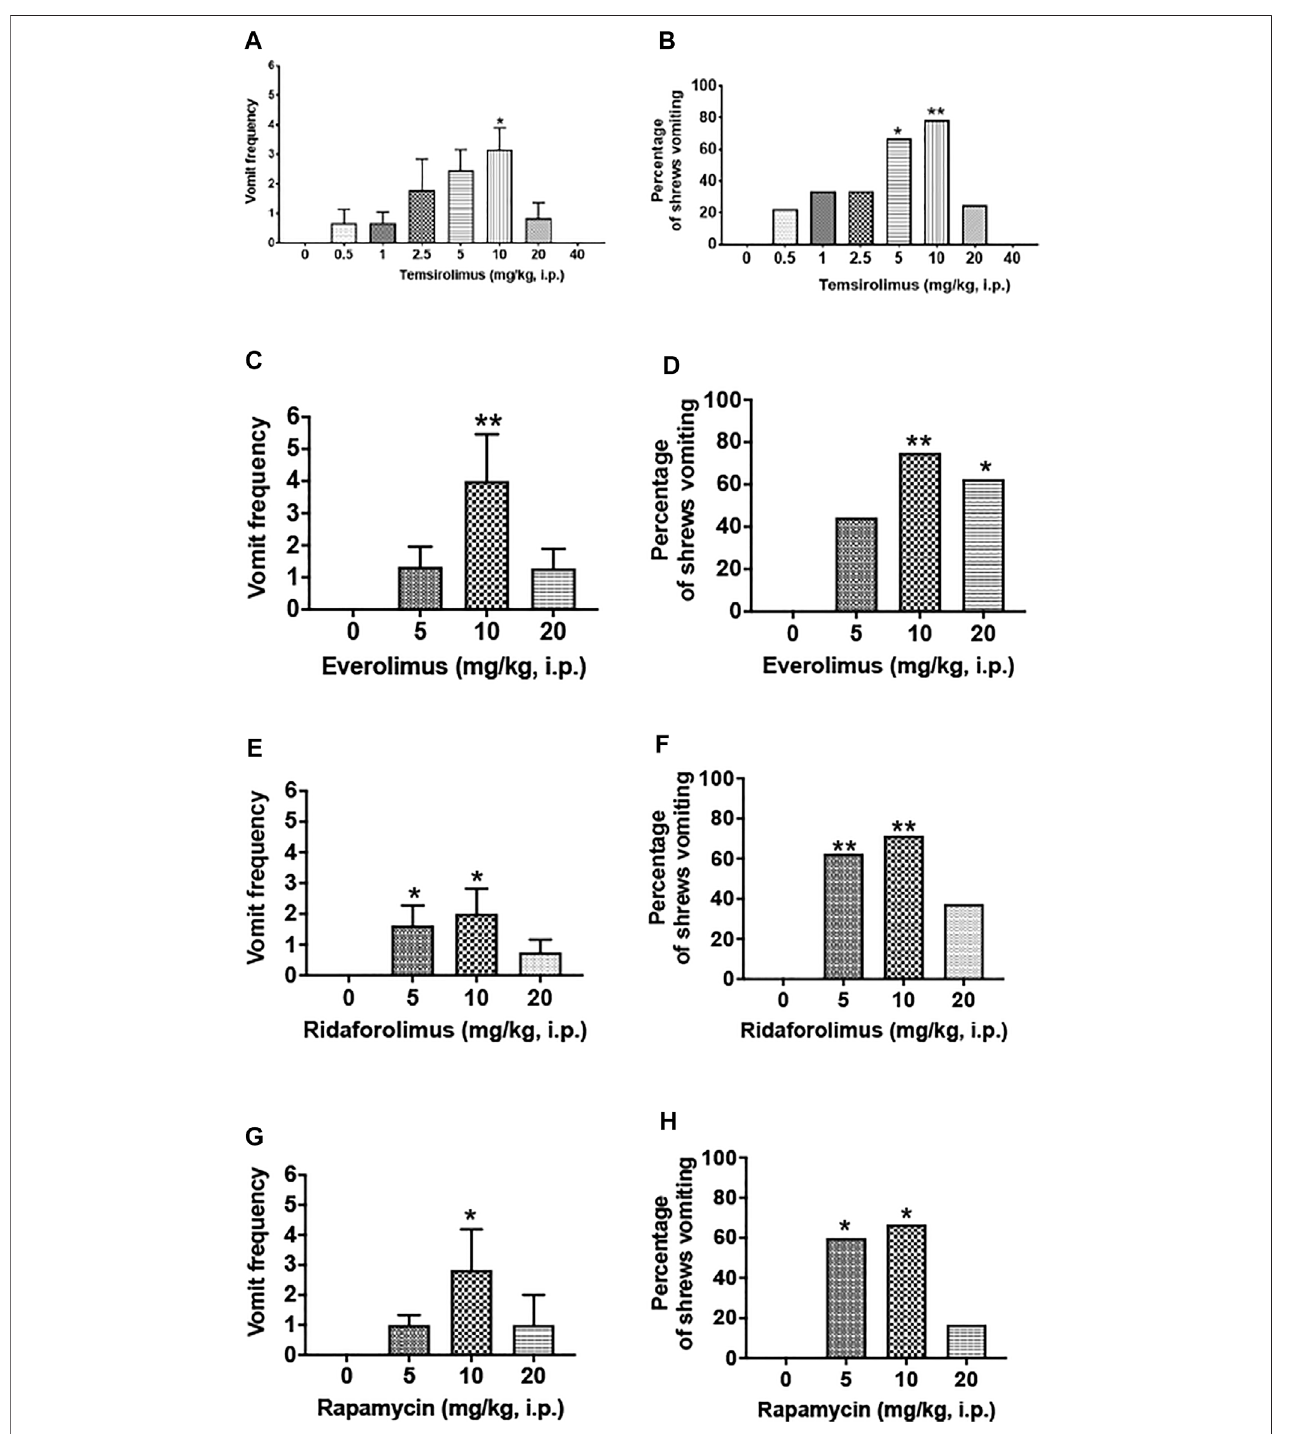
FIGURE 2 | Emetic effects of varying doses of temsirolimus and its analogs in the least shrew. Different groups of shrews received either an injection of corresponding vehicle (25% DMSO, i.p.) or varying cited doses of temsirolimus or its analogs everolimus, ridaforolimus, and rapamycin. Emetic parameters were recordedfor30 minpost-emeticinjection. Graphs (A,B) respectivelyrepresentthemeanfrequencyofvomiting(±SEM)and thepercentage ofshrews vomitingfollowing temsirolimus administration. Similarly, graphs in (C,D) , (E,F), and (G,H), respectively, show corresponding emetic parameters for everolimus, ridaforolimus, and rapamycin. For each of the aforementioned experiment, signi fi cance in the frequency of vomiting was obtained using a Kruskal – Wallis non-parametric one-way ANOVA followed by Dunnett ’ s post hoc test and expressed as the mean ± SEM. Chi-square test was used to determine signi fi cant differences in the percentage of shrews vomiting relative to the corresponding vehicle control groups (25% DMSO). Signi fi cant differences are indicated as * p < 0.05; ** p < 0.01.